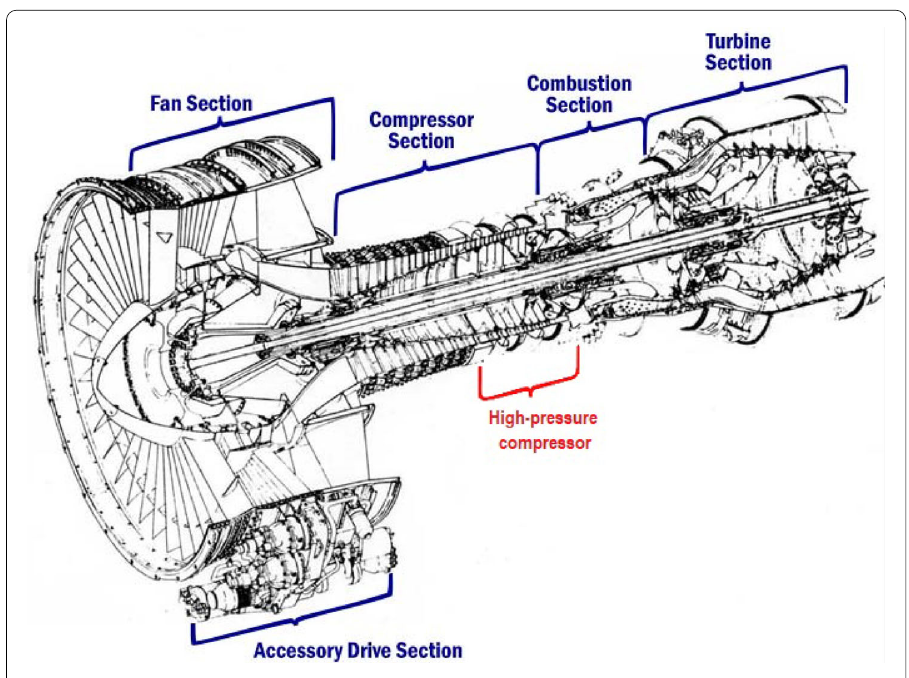
Fig. 1 CF6-6 engine cutaway [1], with an emphasis on the high-pressure